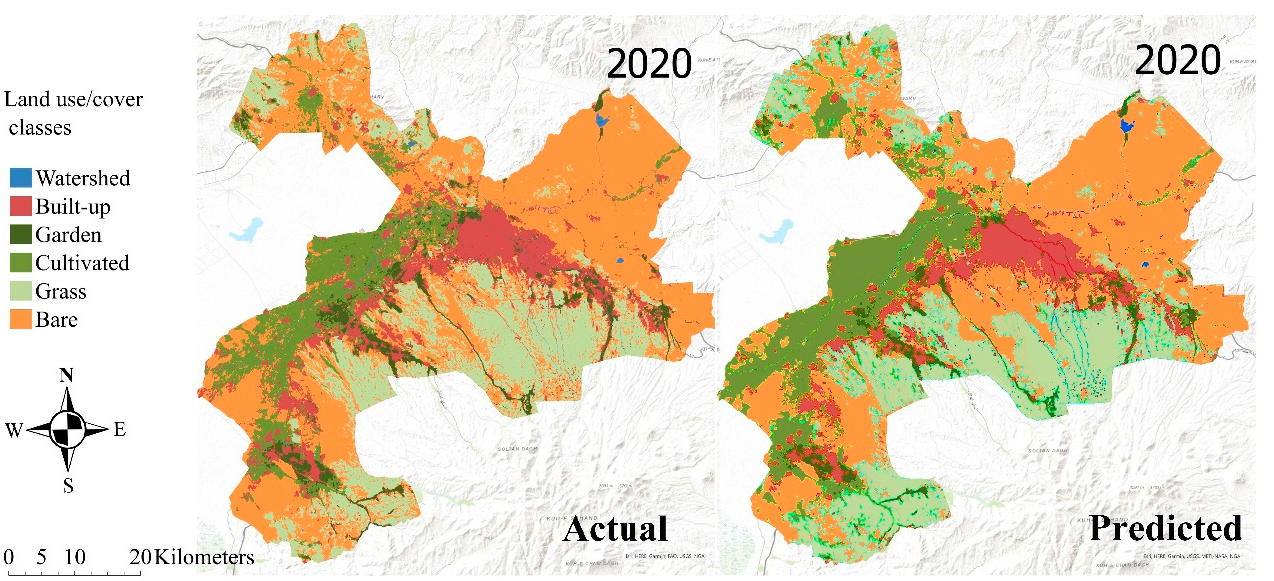
Figure 8. The result of the experimental prediction of the CA–MARKOV model for 2020.